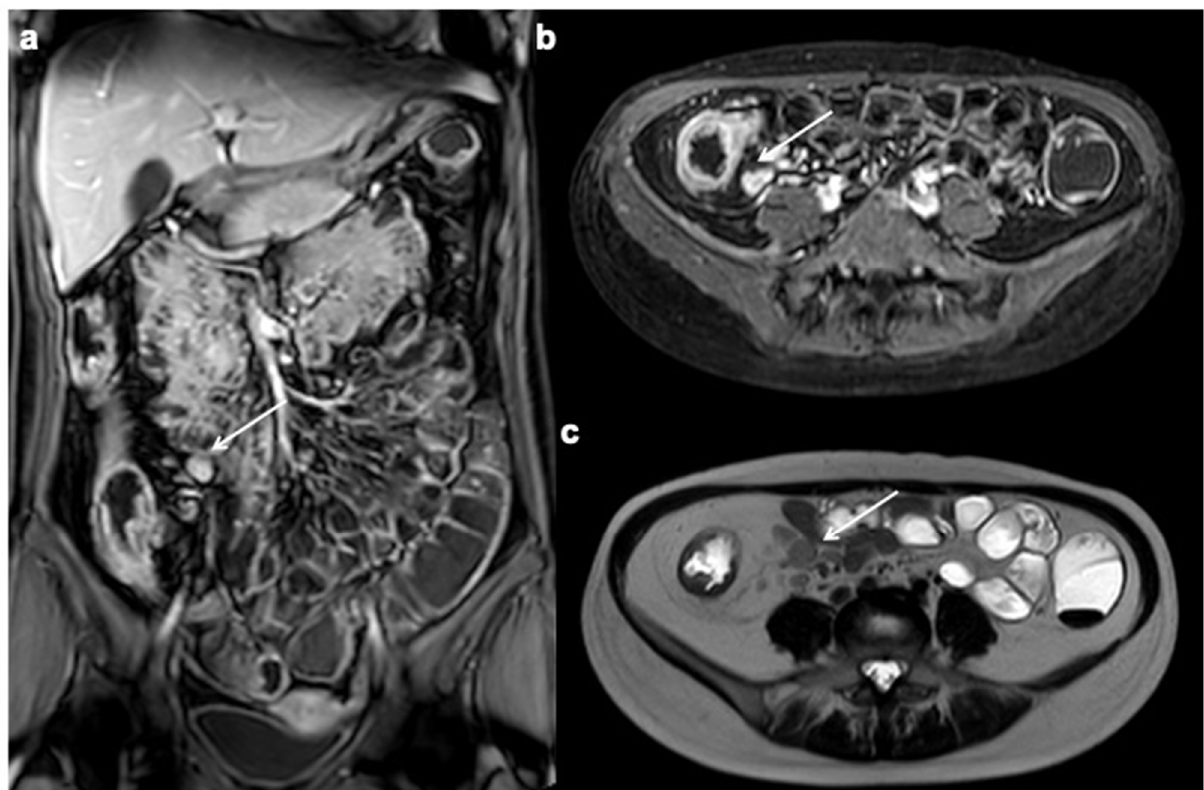
Figure 8. Lymphadenopathy. Coronal, axial contrast-enhanced fat-suppressed T1 weighted portal venous phase ( a – c ) and axial T2 FSE without FS show a lot of mesenteric enlarged lymph nodes (up to 1–1.5 cm in diameter on the short axis) (white arrows).